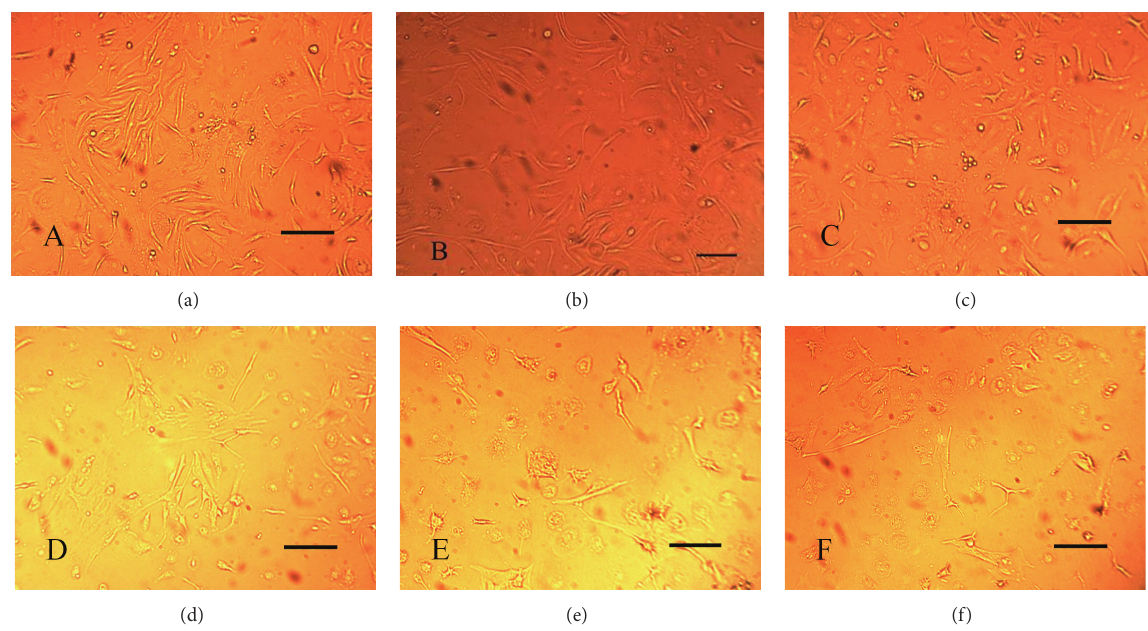
Figure 1: The inhibition effect of LPS on decidua cell growth. (a) 0 ng/mL LPS, the cells were normal, (b) 1ng/mL LPS, very few cells were dead, (c) 10ng/mL, few cells were dead, (d) 100ng/mL LPS, 50% of the cells were dead, (e) 500 ng/mL LPS, most of the cells were dead, and